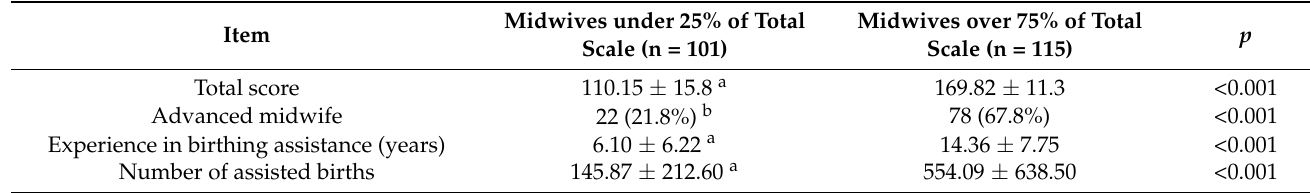
Table 3. Examination of validity using good–poor